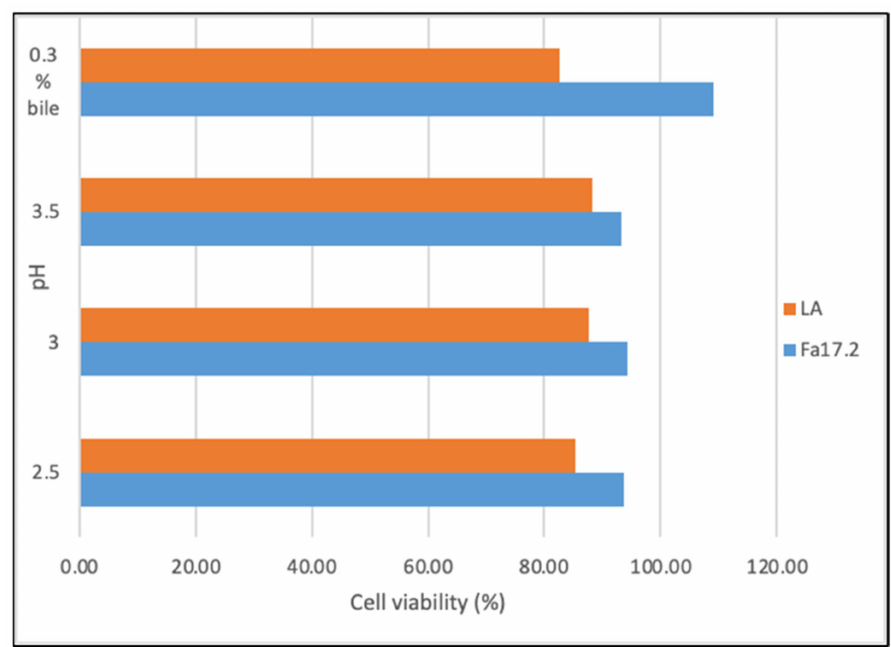
Figure 2. Cell viability (%) upon incubation with gastric juice at different pHs and bile salt (0.3%). Legend: Fa17.2: B. subtilis Fa17.2; LA: L. acidophilus